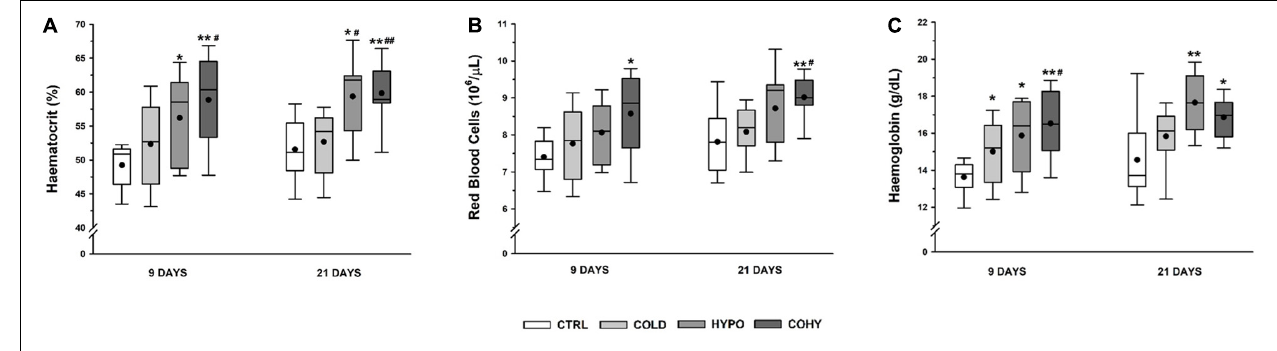
FIGURE 3 | Hematological parameters after 9 and 21 days. (A) Hematocrit; (B) red blood cell counts; (C) hemoglobin concentration. CTRL, control; COLD, intermittent cold; HYPO, intermittent hypoxia; COHY, intermittent cold + hypoxia. Statistically significant differences are indicated as follows: * p < 0.05 vs. CTRL, ** p < 0.001 vs. CTRL, # p < 0.05 vs. COLD, ## p < 0.001 vs. COLD. Sample size: n = 8–13 per group at each temporal time point.